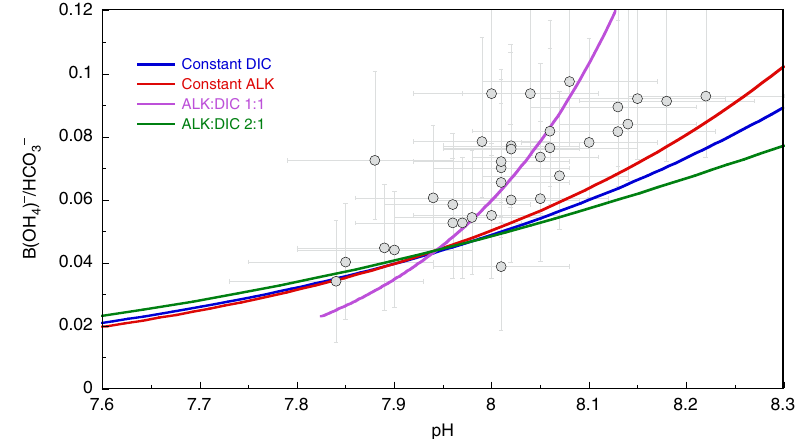
Fig. 3 Sensitivity of pH vs. [B(OH) 4 - /HCO 3 − ] sw relationship to DIC and ALK. pH estimates derived from boron isotope reconstructions 35 and ad hoc B/ Ca-B(OH) 4 − /DIC and B/Ca-[B(OH) 4 − /HCO 3 − ] sw calibrations (see Methods) are plotted for a range of scenarios with changes in the dissolved inorganic carbon (DIC) and alkalinity (ALK) inventory. Blue and red line indicate scenarios with constant DIC and ALK, respectively. Purple and green lines indicate changes with a ALK:DIC ratio of 1:1 and 2:1. We plot one δ 11 B sw 35,66 (G17) scenario to highlight the overall relationships present and provide full carbonate system estimates in the Methods. Monte Carlo uncertainty estimates (95% CI) are plotted for pH 35 and [B(OH) 4 − /HCO 3 − ] sw